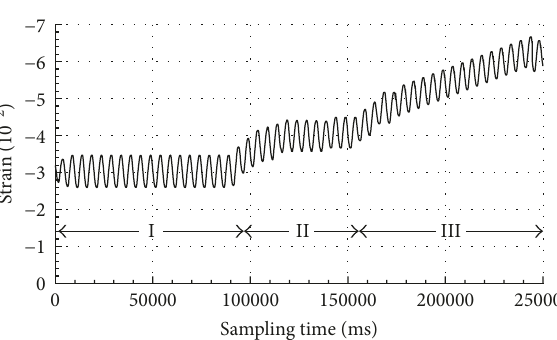
Figure 4: Strain curve of test piece no. 3 for the test with or- thogonal method ( T 10 ° C, (cid:31) −